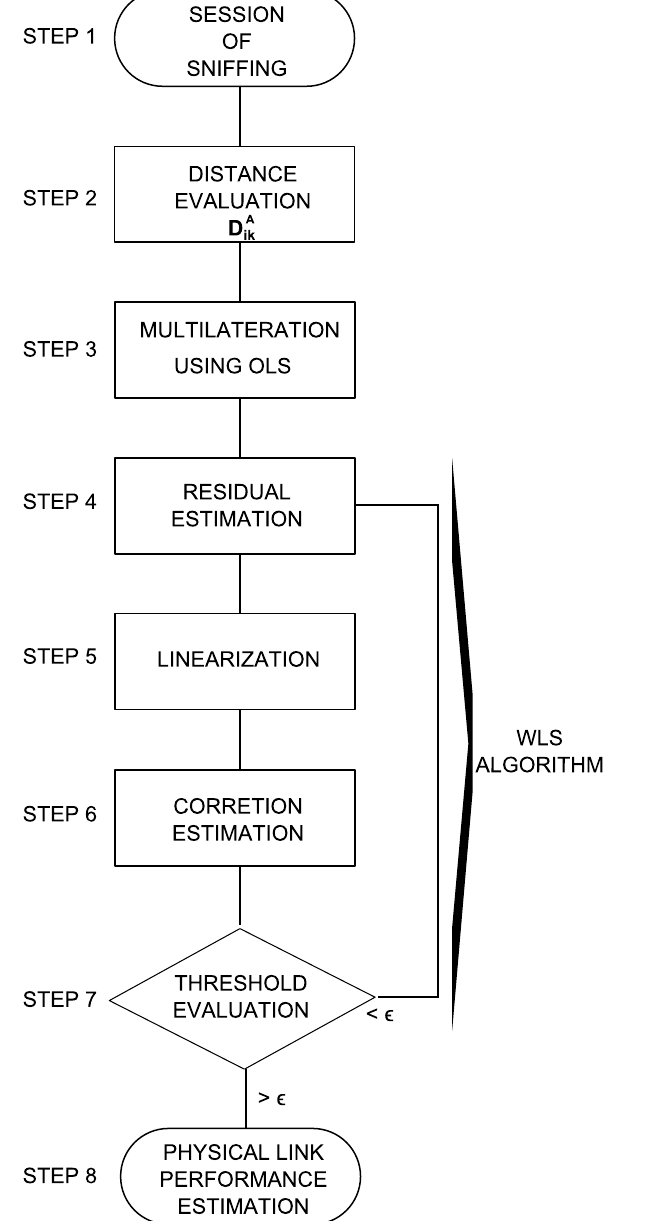
Figure 4. Flow diagram for the proposed